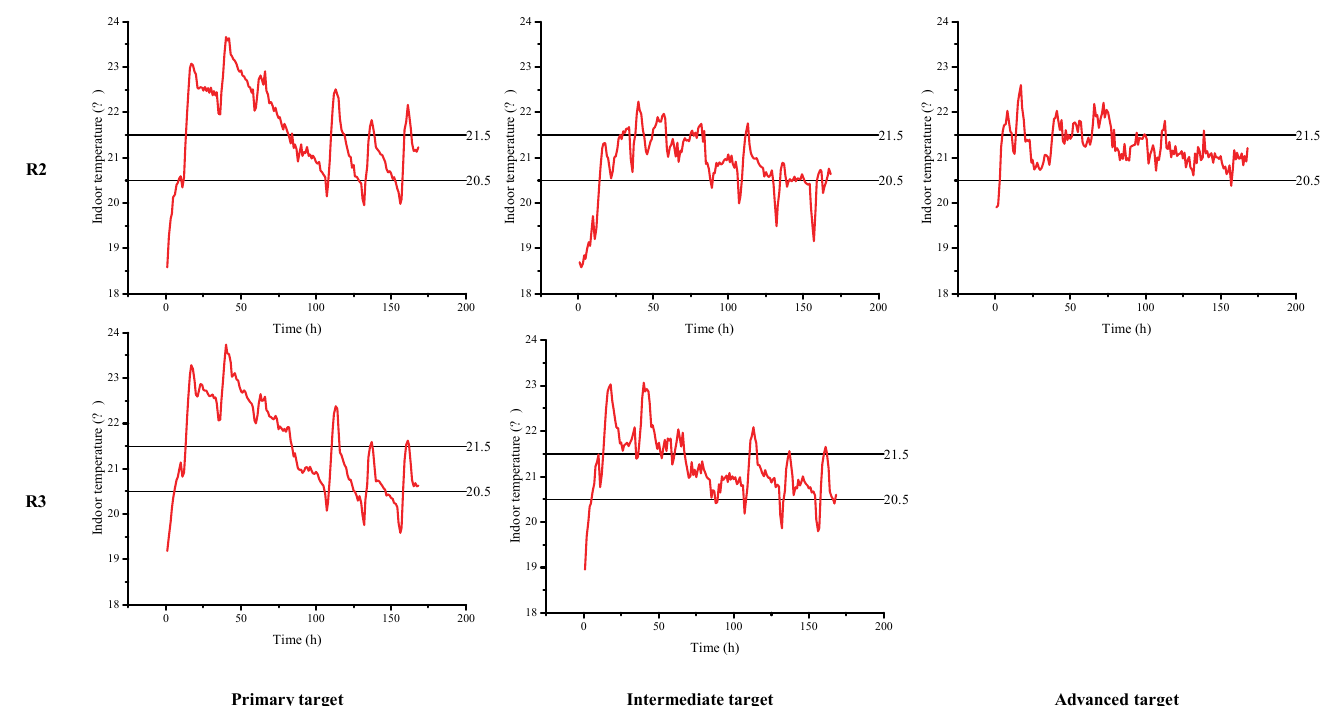
Figure 12. Results of indoor temperature controlled by different prediction models.